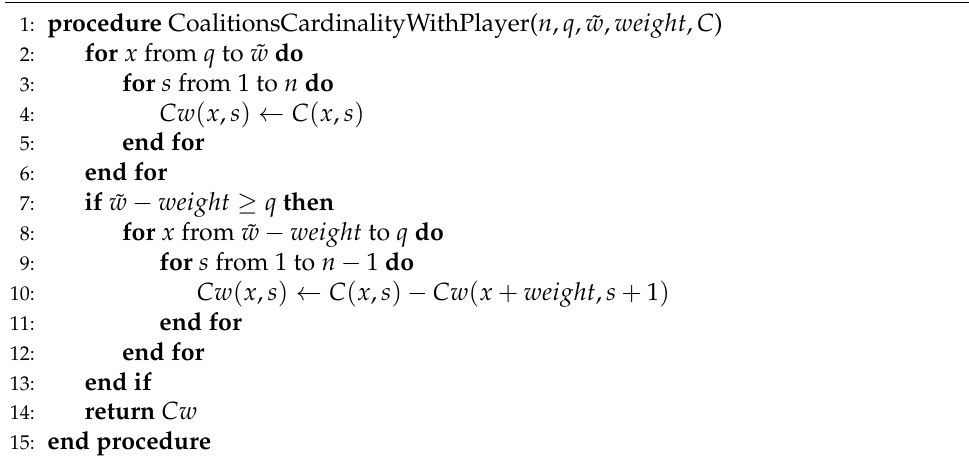
Algorithm 5 Count coalitions and cardinalities containing a player specified by its